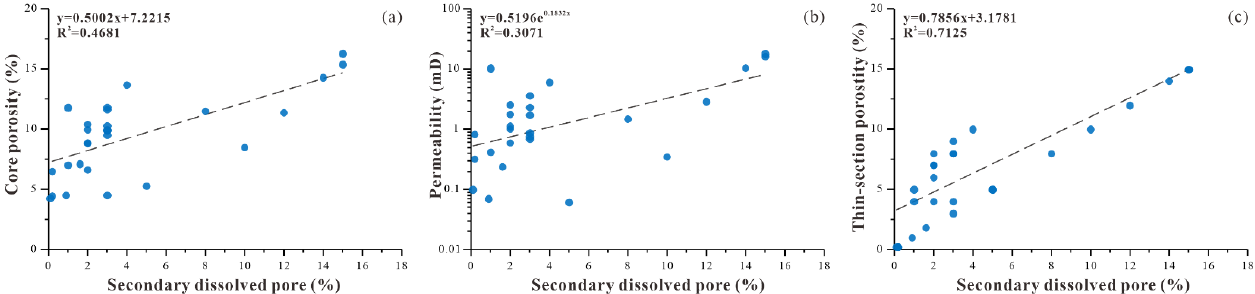
Figure 20. Cross-plots showing the relationship between secondary dissolved pore and ( a ) core porosity, ( b ) core permeability, and ( c ) thin-section porosity.